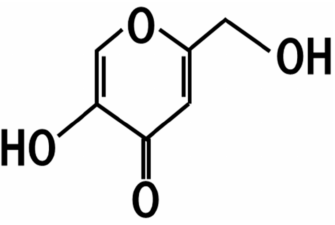
Figure 3. Chemical structure of Kojic